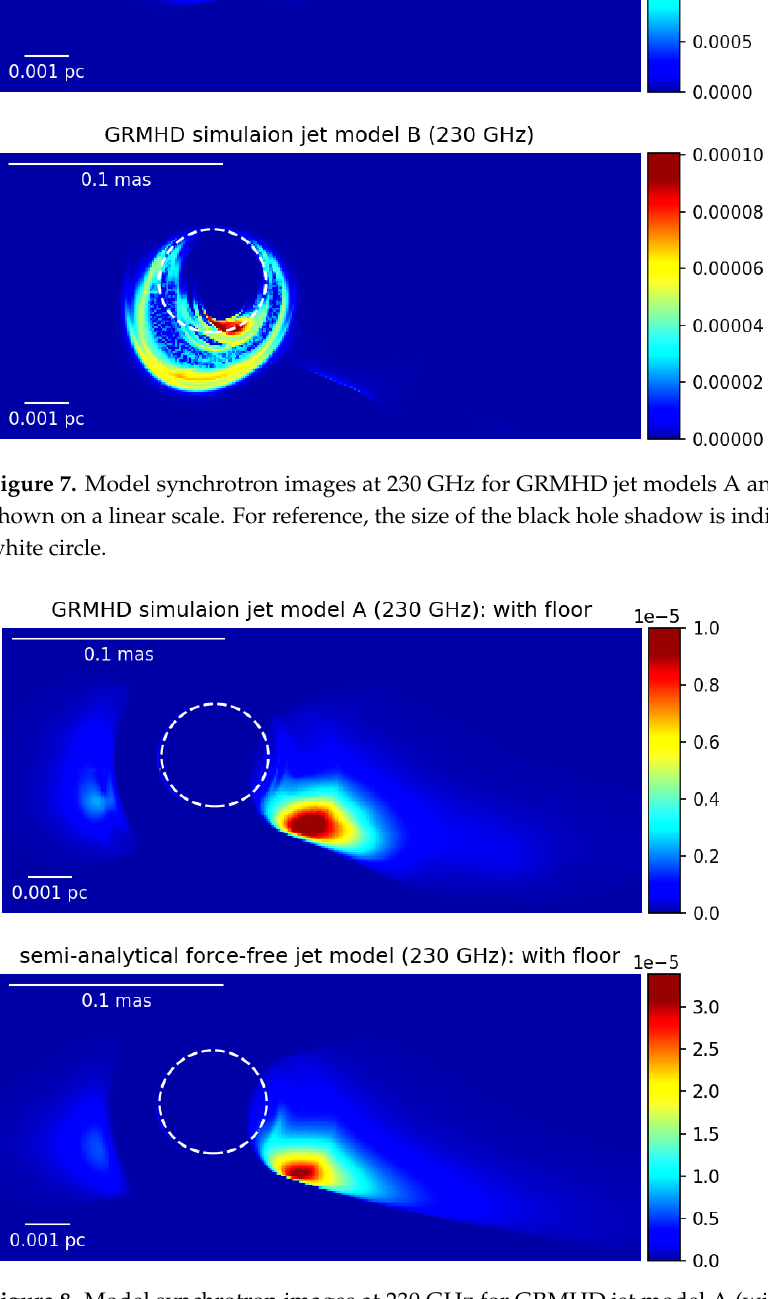
Figure 8. Model synchrotron images at 230 GHz for GRMHD jet model A (with the floor) and the force-free jet model (with the floor). The images are shown on a linear scale. For reference, the size of the black hole shadow is indicated by the dashed white